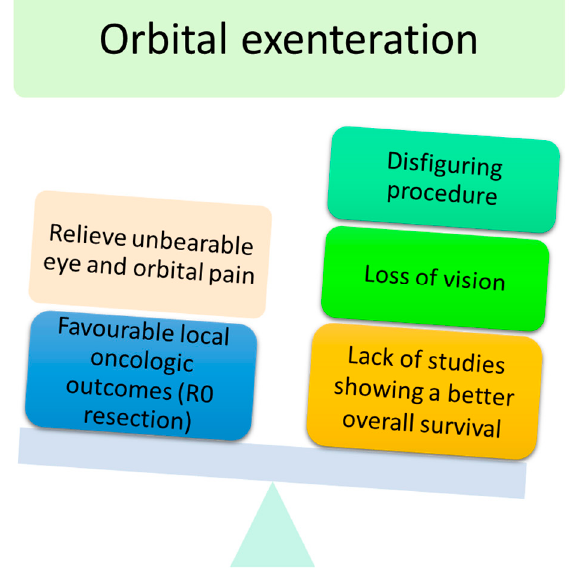
Figure 4. Main advantages and disadvantages of orbital exenteration.